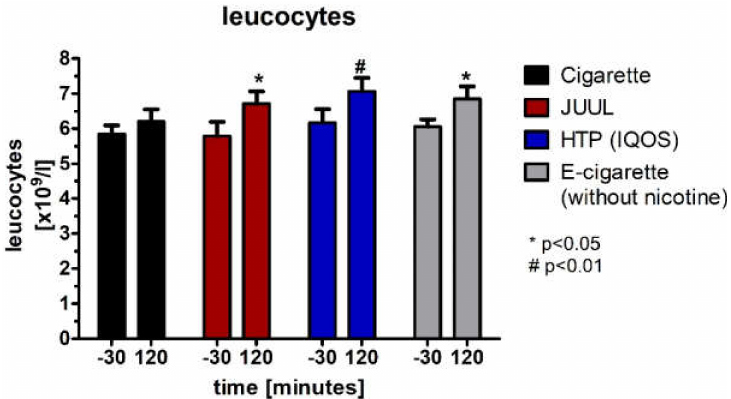
Figure 11. Leucocytes analyzed before, as well as 120 min after consuming the cigarette, JUUL TM , heated tobacco product, and e-cigarette without nicotine. Table 4. Changes within the hemogram analyzed before as well as 120 min after consuming the cigarette, JUUL TM , heated tobacco product, and e-cigarette without nicotine.